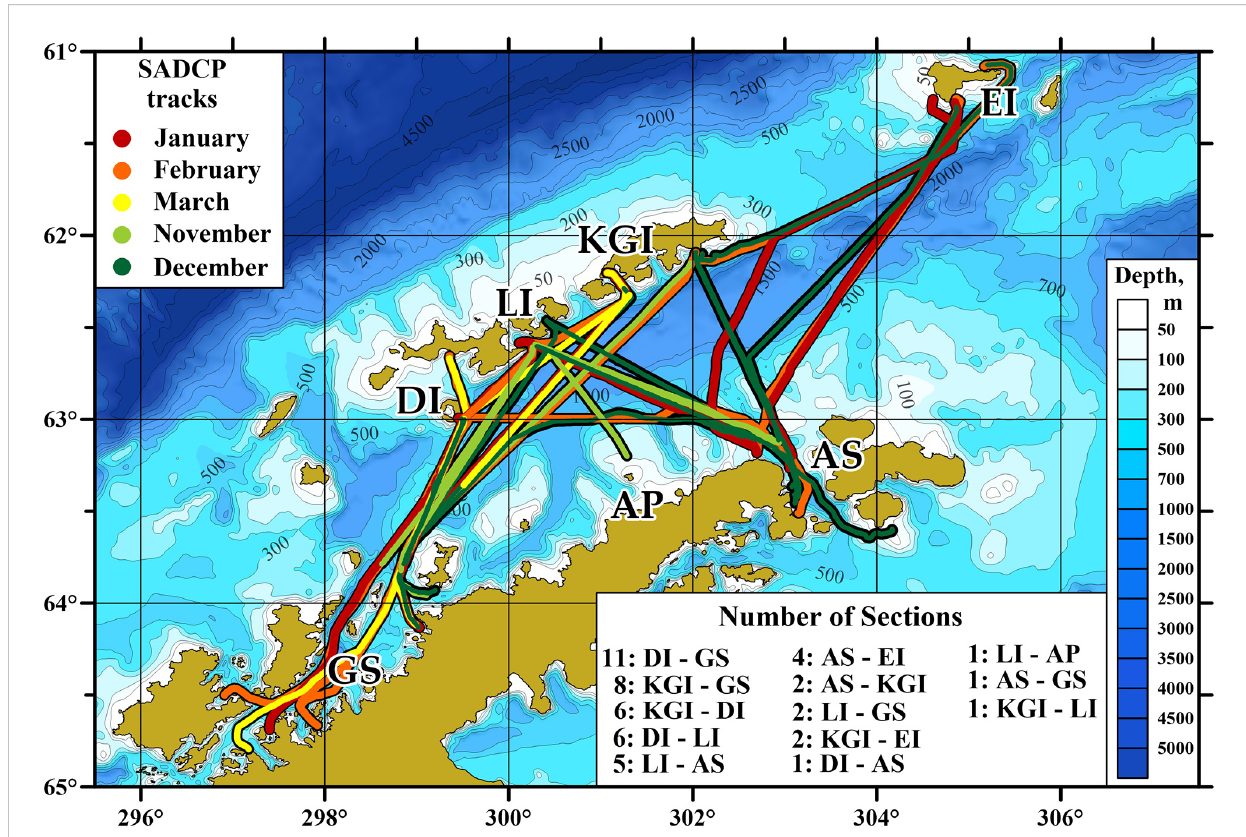
FIGURE 2 Ship tracks with SADCP measurements in the Brans fi eld Strait used in this work. Different colors indicate measurements performed in different months of 2017. Locations of starting and ending points of tracks are indicated: AS, Antarctic Sound; EI, Elephant Island; KGI, King George Island; DI, Deception Island; GS, Gerlache Strait; LI, Livingston Island; AP, Antarctic Peninsula (see Figure 1 for locations of the islands). Number of sections along different routes are presented; see Table 1 for more detailed information. Bathymetry is shown according to the GEBCO2019